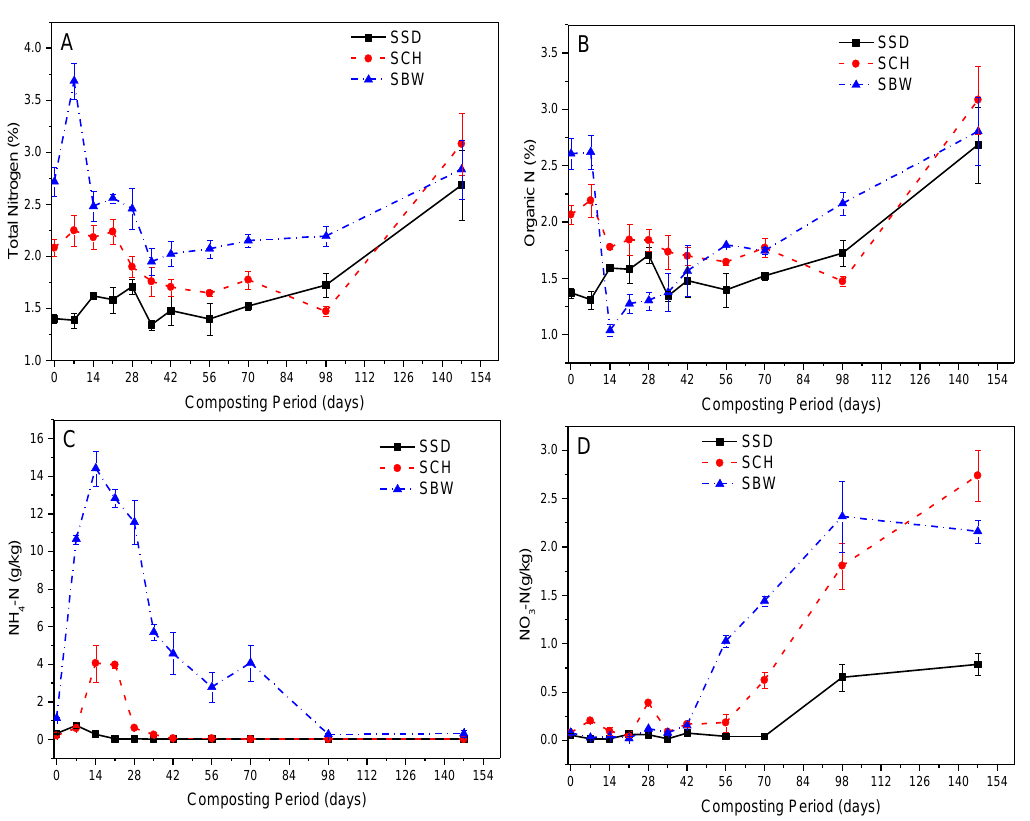
Figure 4. Evolution of: ( A ) total Nitrogen (TN); ( B ) organic nitrogen; ( C ) ammonium-nitrogen (NH 4+ -N); and ( D ) nitrate-nitrogen (NO 3− -N) during the composting of faecal sludge-FS with brewery waste-SBW, coffee husks-SCH, and sawdust-SSD. Error bars represent the standard error of n = 2.